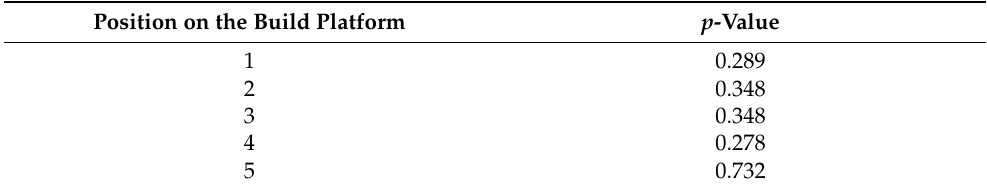
Table 5. Significance of Levene’s test when comparing different positions on the build platform at the Y-axis according to the p